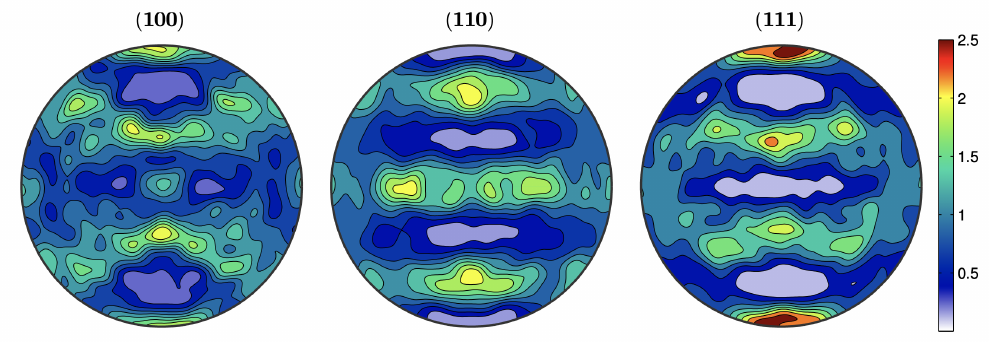
Figure 1. Pole figure of the pure Cu 99.9% material. Directions are indicated above the